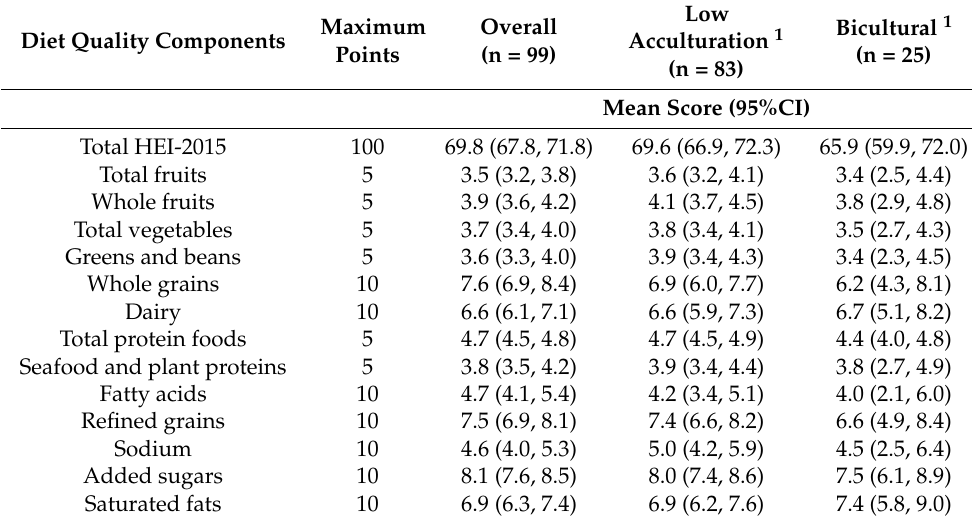
Table 3. Average diet quality score differences by